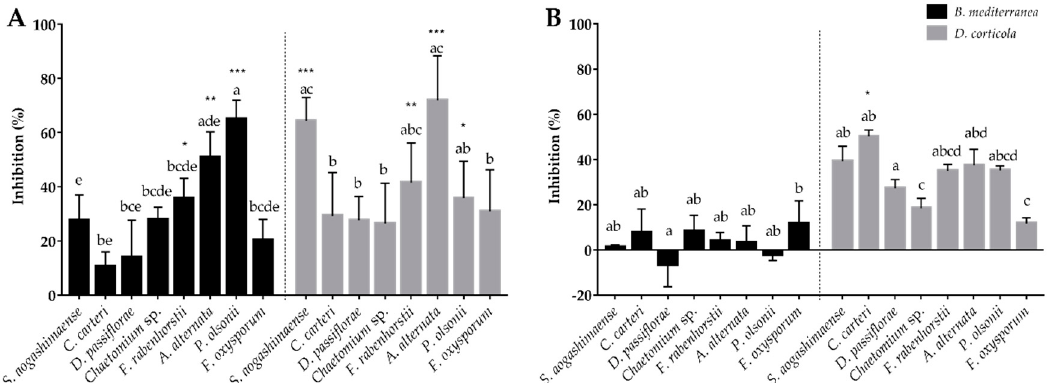
Figure 6. Inhibition of B. mediterranea and D. corticola growth caused by non-volatile ( A ) and volatile compounds ( B ) produced by the tested endophytic fungi. Negative values indicate that the area of the plate covered by the interacting pathogen was higher than that of the control. Different letters represent statistical significance ( p < 0.005) between endophytes in each antagonistic assay and * ( p ≤ 0.05), ** ( p ≤ 0.01) and *** ( p ≤ 0.001) represent statistical significance between the control